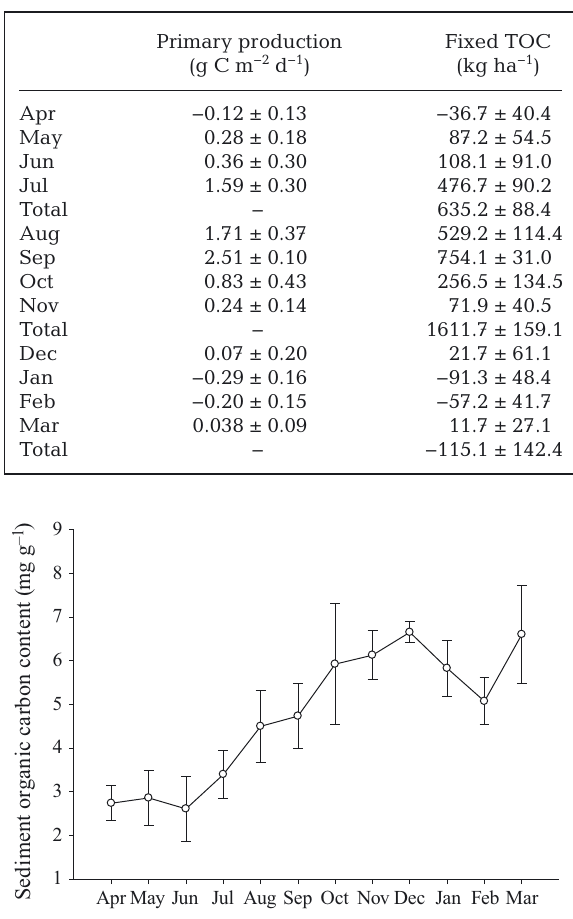
Table 3. Inputs and outputs of organic carbon (mean ± SD, n = 3) in polyculture seawater ponds without feeding during different farming seasons and the annual carbon